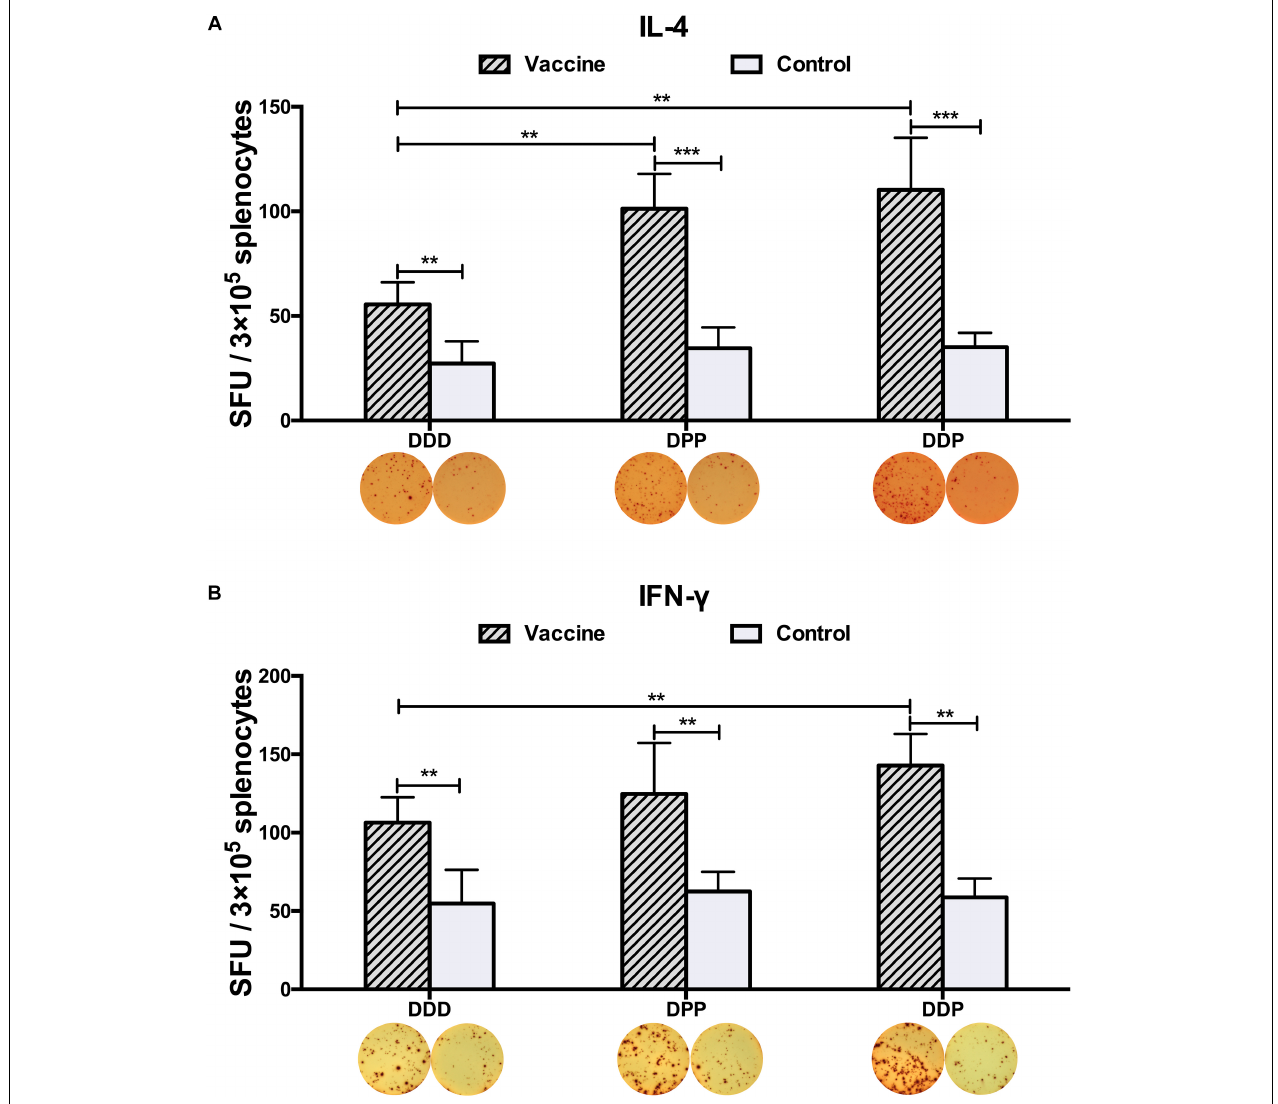
FIGURE 3 | DENV2-specific cytokine-secreting splenocytes in different immunization groups. Cytokine-secreting splenocytes were determined after stimulation with purified DENV2 particles. The positive splenocytes were counted and expressed as the mean SFU/3 × 10 5 cells. (A) IL-4-positve and (B) IFN- γ -positive splenocytes with representative ELISPOT images, respectively. Data were expressed as mean + SD ( n = 8). ∗∗ P < 0.01, ∗∗∗ P <